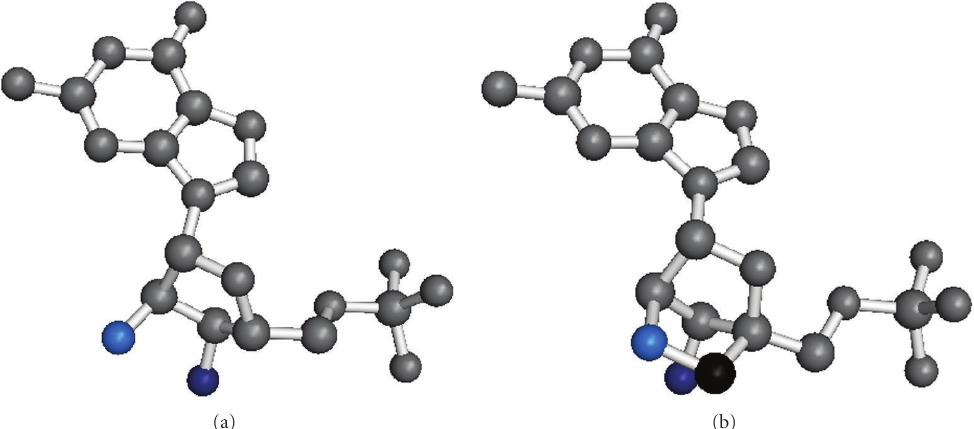
Figure 1: Guanosine monophosphate shown as RNA nucleotide (a) and as LNA nucleotide with the 2 (cid:2) - O ,4 (cid:2) - C -methylene- β -D-ribofuranose modification (b). Oxygen atoms are coloured in light blue (2 (cid:2) -oxygens) and dark blue (3 (cid:2) -oxygens), respectively. The additional carbon atom from the methylene group in the LNA is shown in black.